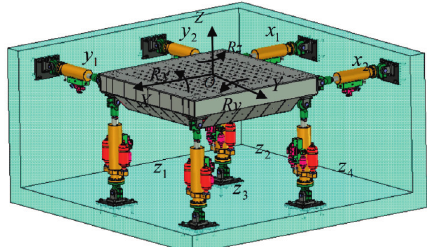
Figure 3: Overall structure of multiaxis hydraulic servo shaking